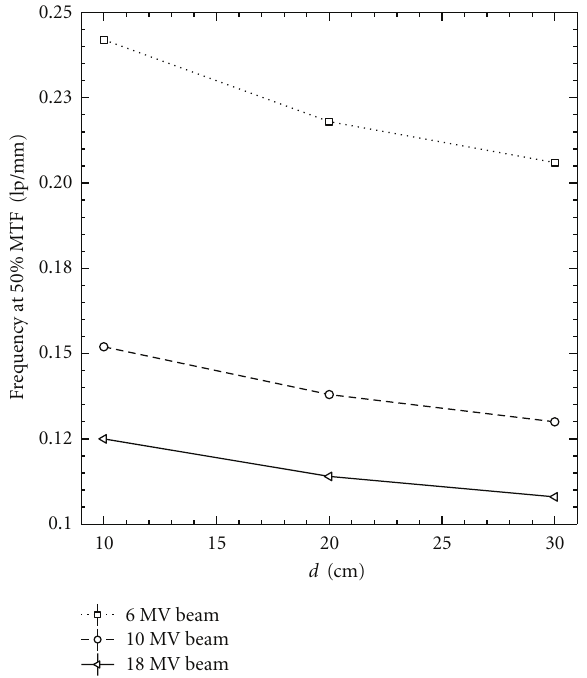
Figure 6: The frequency ( f 50 ) at 50% of the MTF as a function of detector thickness for di ff erent beam energies. The entrance spectra of X rays (see Figure 2) were used in the simulation.